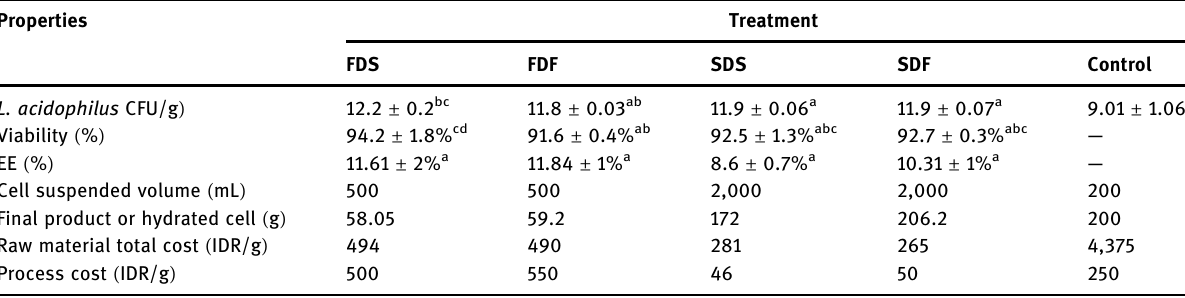
Table 4: The e ff ect of treatment on various parameters observed